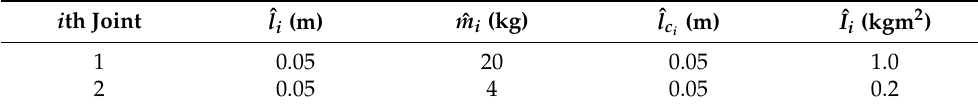
Table 2. Initial rough parameters of the 2-DOF robot manipulator.